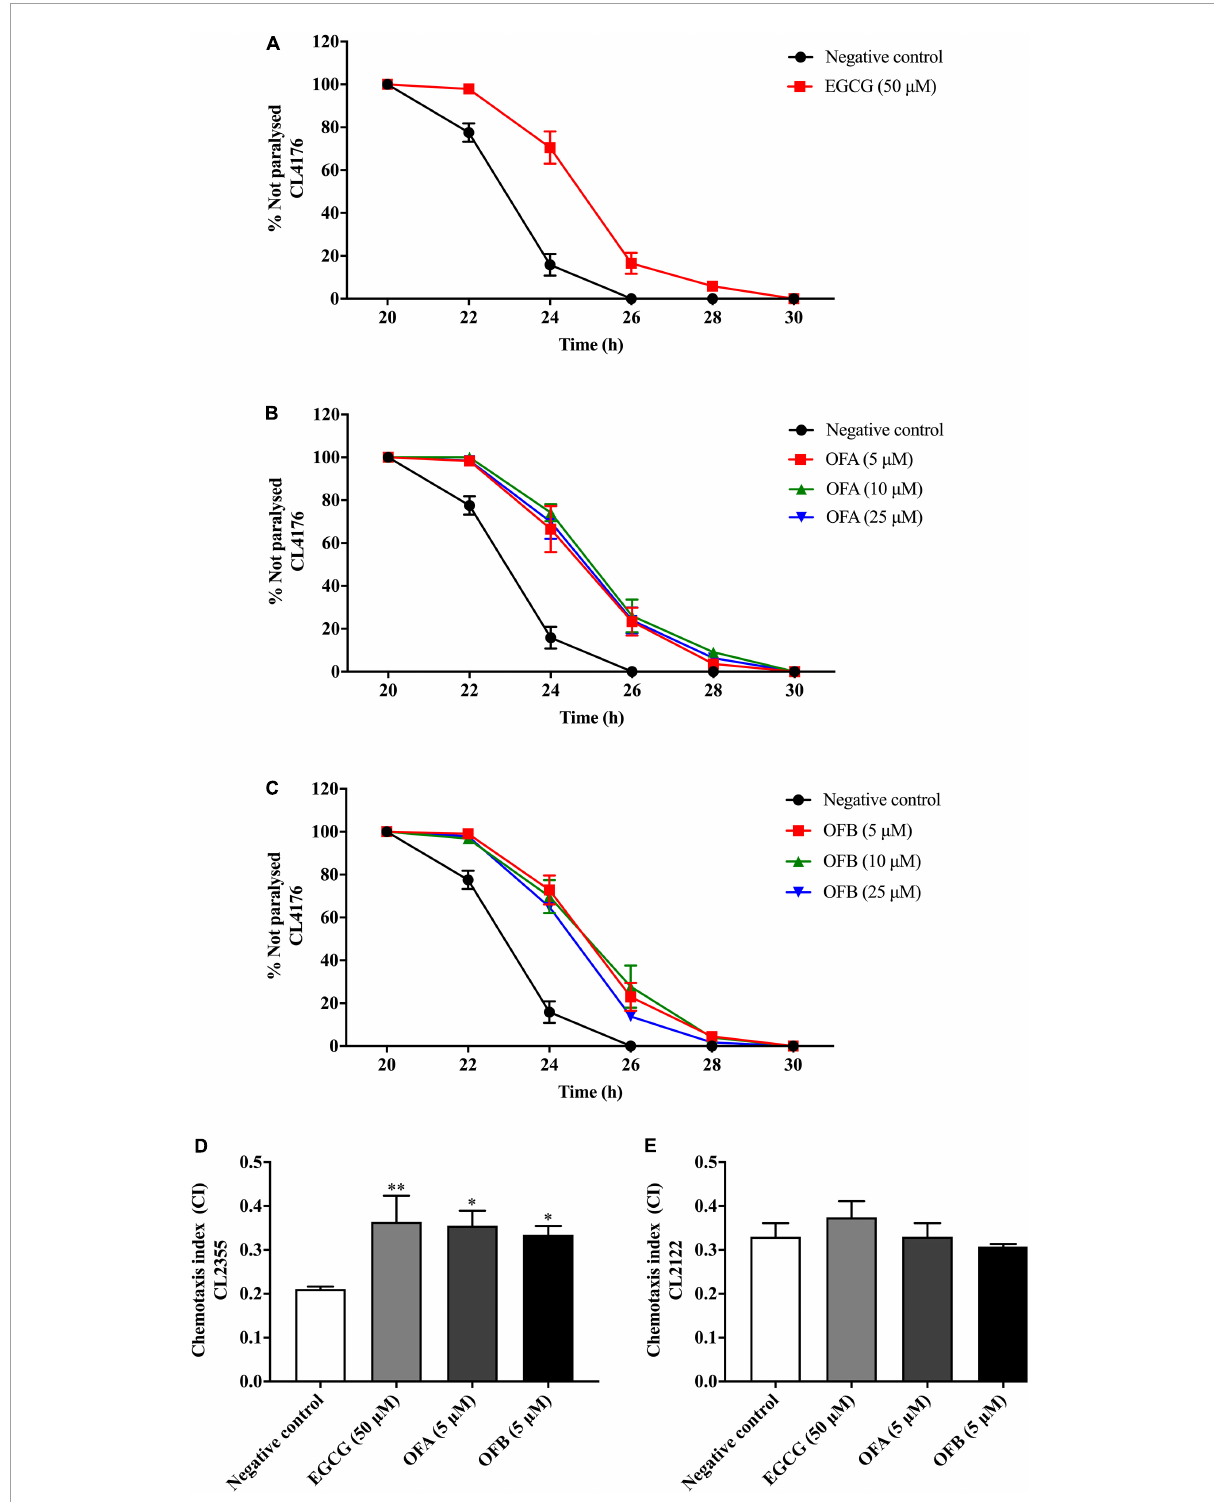
FIGURE5 Effect of EGCG, OFA, and OFB on A β -induced paralysis in transgenic stain AD model CL4176 (A–C) . The indicated times are from the initiation of the temperature shift up. Effect of EGCG, OFA, and OFB on A β -induced deficit in chemotaxis behavior in transgenic strain AD model CL2355 (D) . EGCG, OFA, and OFB didn’t affect the chemotaxis behaviour of the control strain CL2122 (E) . All data are shown as the mean ± SEM ( n ≥ 3 independent experiments). ∗ p < 0.05, ∗∗ p < 0.01 compared to the negative